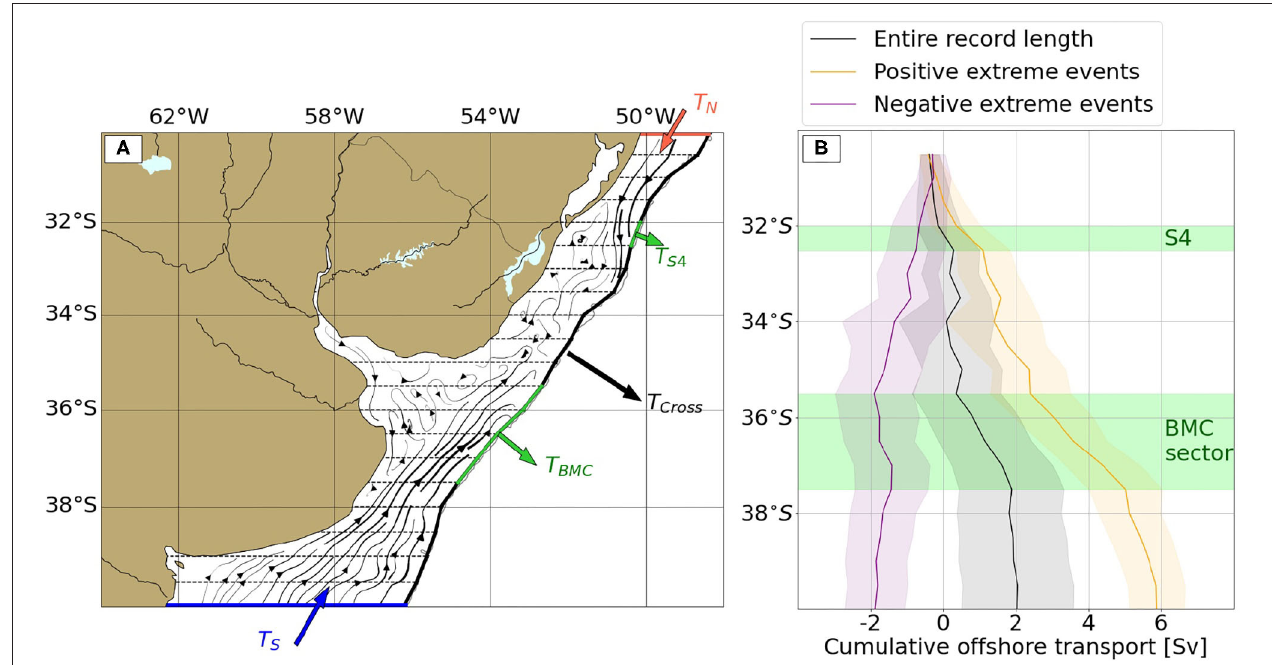
FIGURE 5 | (A) Streamlines over the shelf show time-mean flow structure for the entire record length. Zonal strips used to estimate cross-shore transports (dashed lines). The 200 m isobath is indicated by a heavy black line. (B) Cumulative offshore transport through the 200 m isobath from 30 ◦ S across the 20 outer shelf segments. Mean offshore transport during the entire model run period (1993–2018, black), positive (orange, offshore) and negative (purple, onshore) extreme events. The transport standard deviations are indicated by the background shading. The BMC sector and S4 are indicated in green.